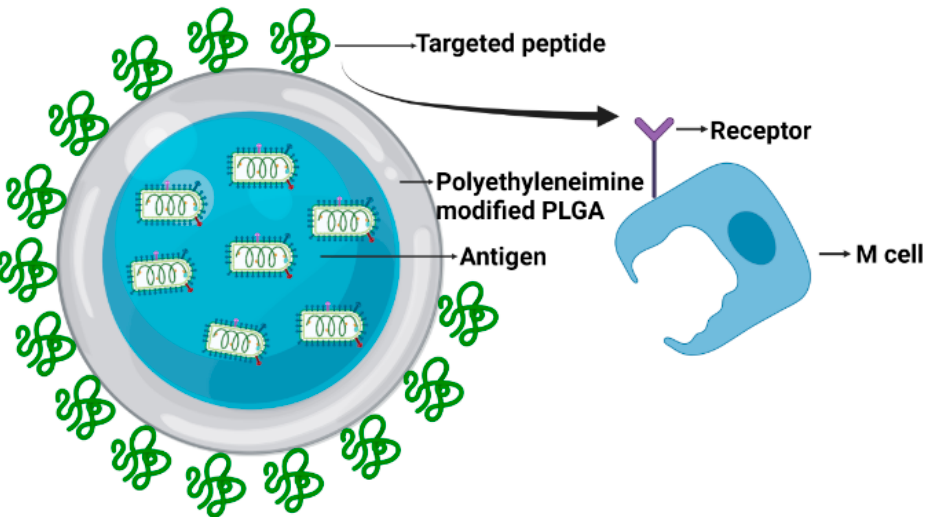
Figure 2. Schematic design of PLGA encapsulated oral COVID-19 vaccine: immunogenic antigen are packaged with PLGA in the form of water-oil-water, then modified with M cell receptor-targeted peptide, targeting M cells in the small intestine and stimulating a mucosal immune response.